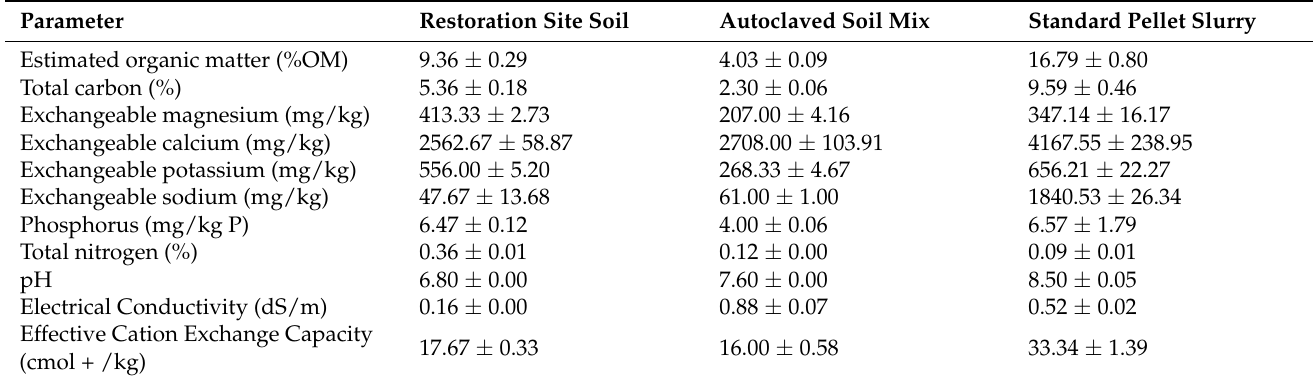
Table 1. Nutrient and physicochemical properties (mean ± SE) of the soil collected at the restoration site at Mount Annan (Trial 1), the autoclaved soil mix (Trial 2), and the standard extruded seed pellet slurry used to form the Standard Pellets. All results presented as a 40 ◦ C oven dried weight. For all sample types, n =